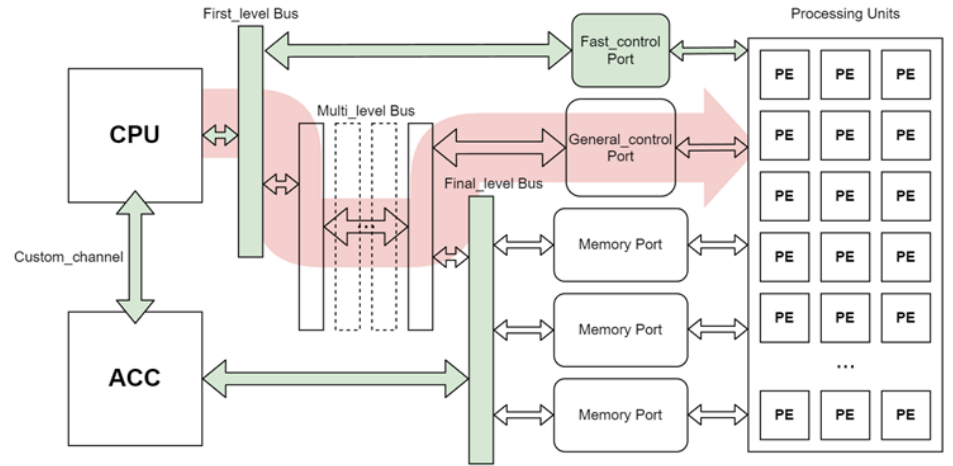
Figure 6. Schematic diagram of system architecture.